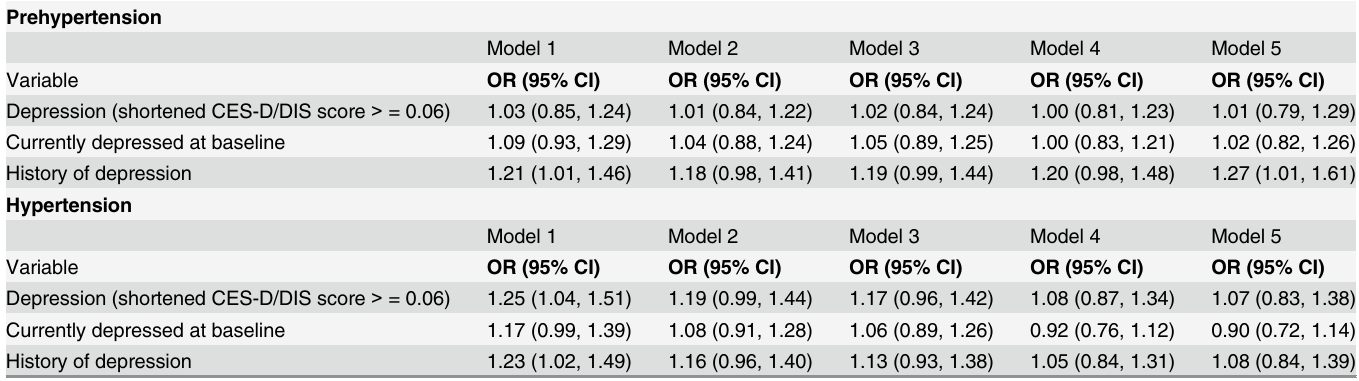
Table 2. Associations of Depression with Baseline Prehypertension and